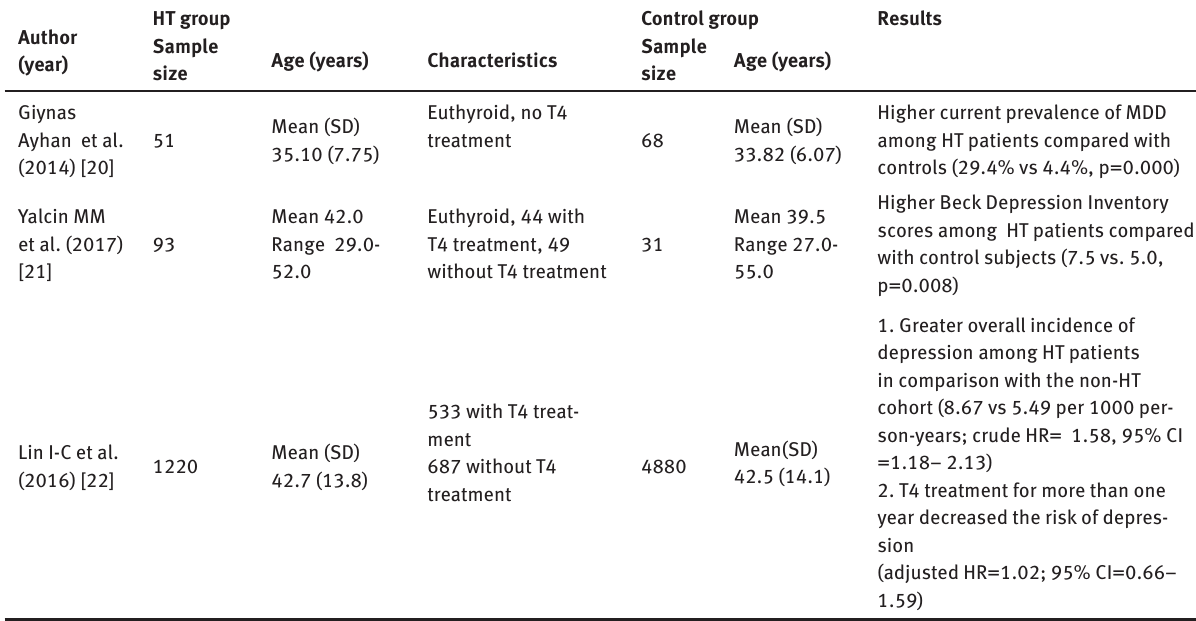
Table 1: Studies assessing the association between Hashimoto‘s thyroiditis and depression